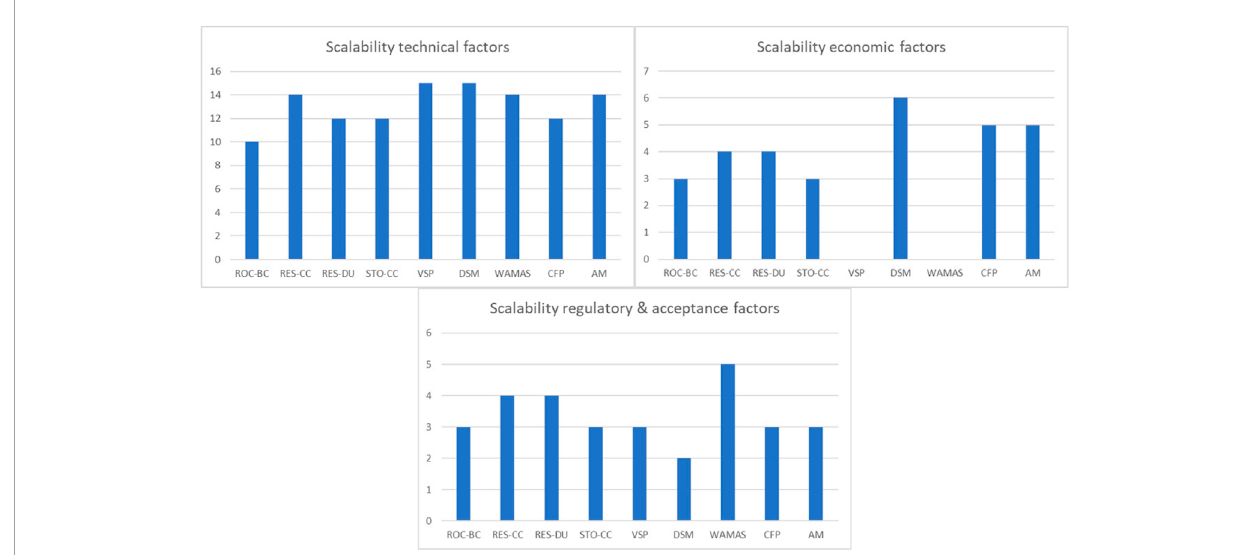
FIGURE 11 Total quantification of scalability factors per CROSSBOW product.